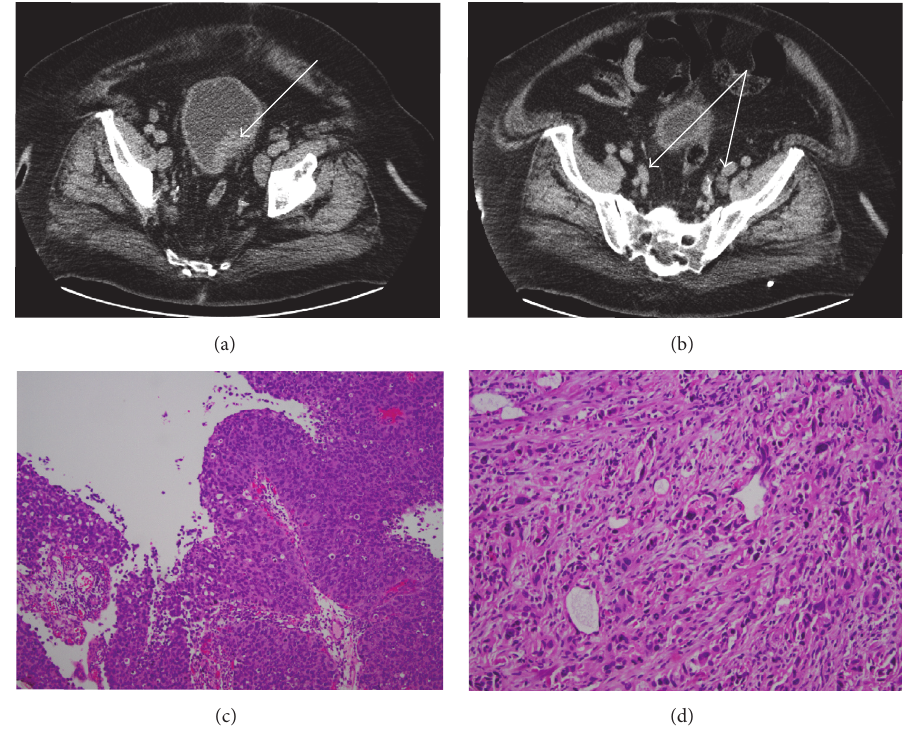
Figure 1: (a) Bladder mass, before chemotherapy. (b) Pelvic lymphadenopathy, before chemotherapy. (c) 100x: biopsy of bladder, before chemotherapy, and surface papillary component of the tumor. (d) 200x: biopsy of bladder, before chemotherapy; shown here are invasive malignant